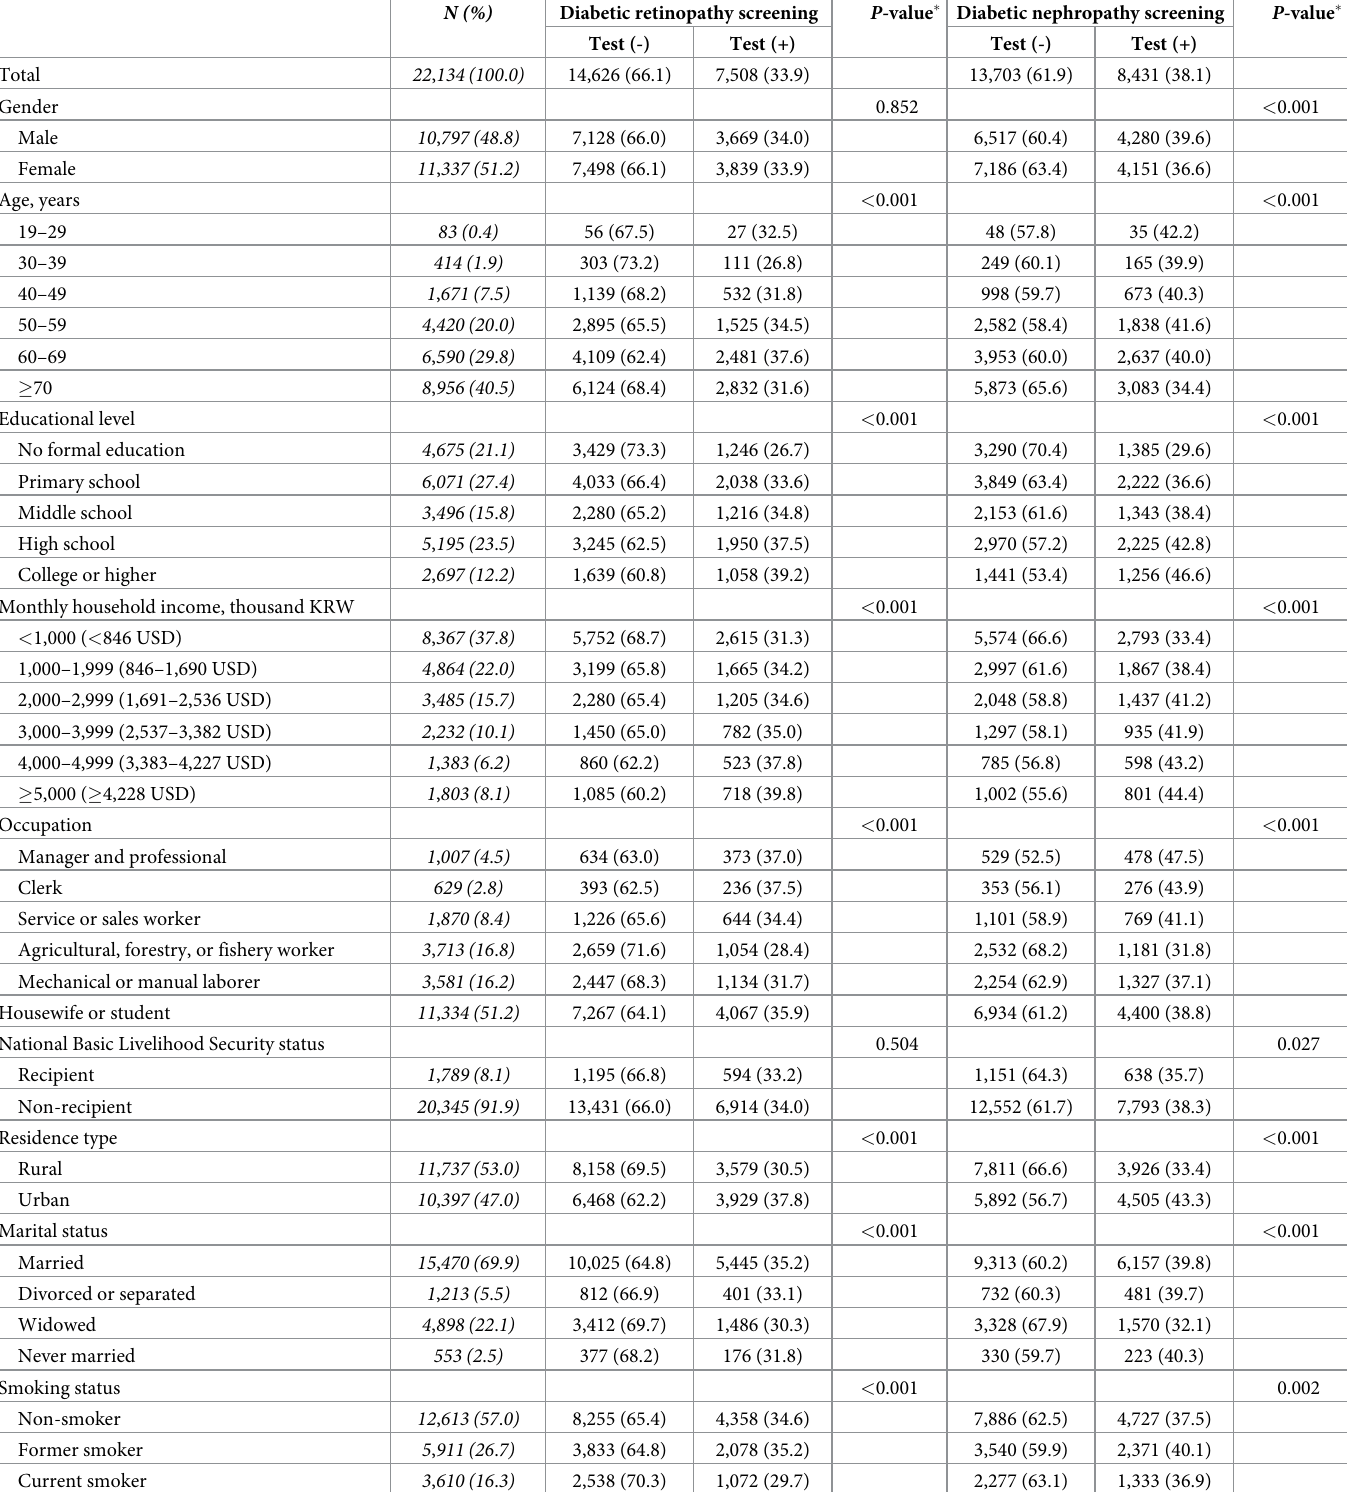
Table 2. General characteristics of the study population according to diabetic retinopathy and nephropathy screening status (n = 22,134). N (%) Diabetic retinopathy screening P -value (cid:3) Diabetic nephropathy screening P -value